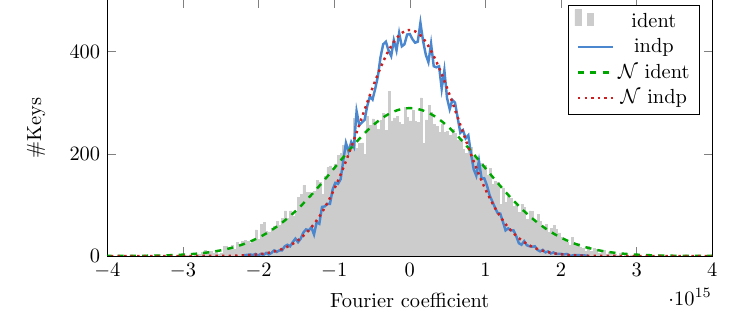
Distribution of Fourier coefficient for Present with R 18 and 10 rounds.